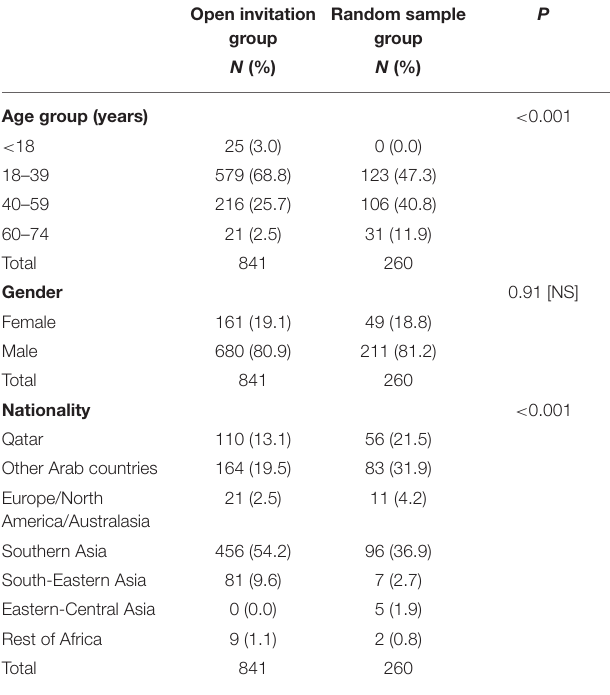
TABLE 1 | Comparing the two study samples by sociodemographic